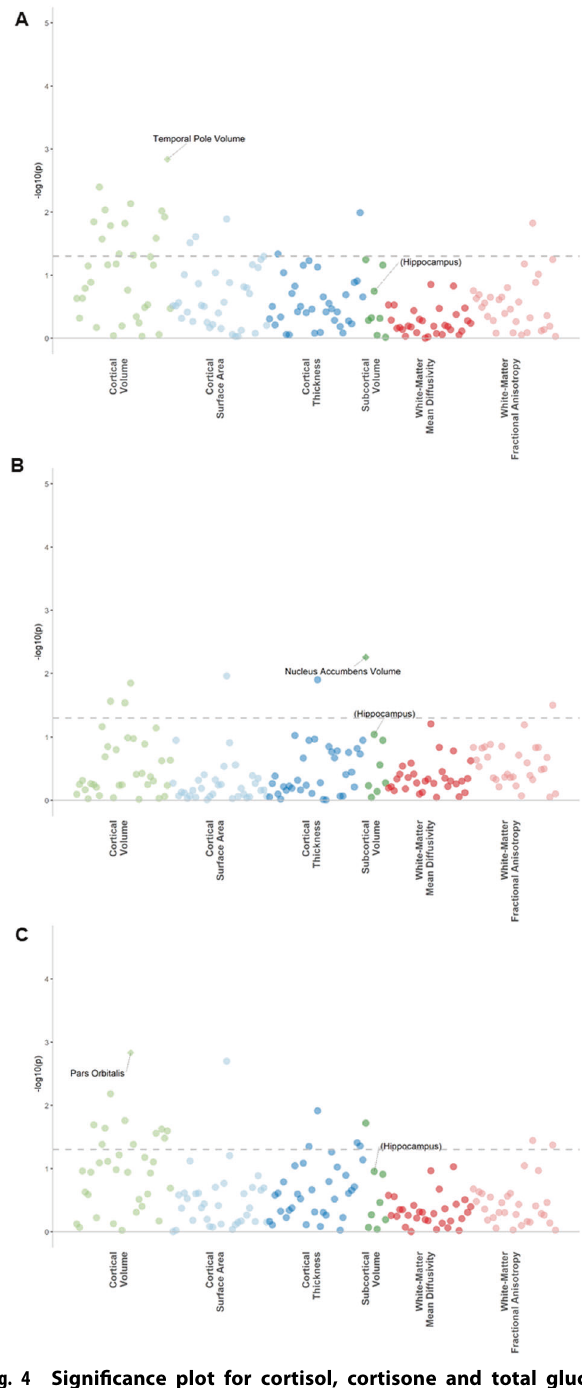
Fig. 4 Signi fi cance plot for cortisol, cortisone and total gluco- corticoid associations with regional structural imaging pheno- types. A Cortisol, B cortisone, and C total glucocorticoid. The x-axes represent structural imaging phenotypes, and the y-axes represent the − log10 of uncorrected p-values between the measure and the imaging phenotype corrected for covariates. Each dot represents one imaging phenotype, and the colours indicate their categories. The dashed lines indicate the p -value threshold of 0.05 and the diamonds represent phenotypes that survive FDR correction. The hippocampus (not signi fi cant) is marked in brackets for reference to previous